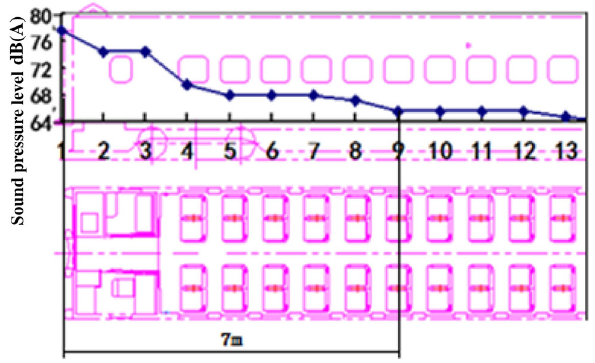
Fig. 1 Longitudinal distribution of interior